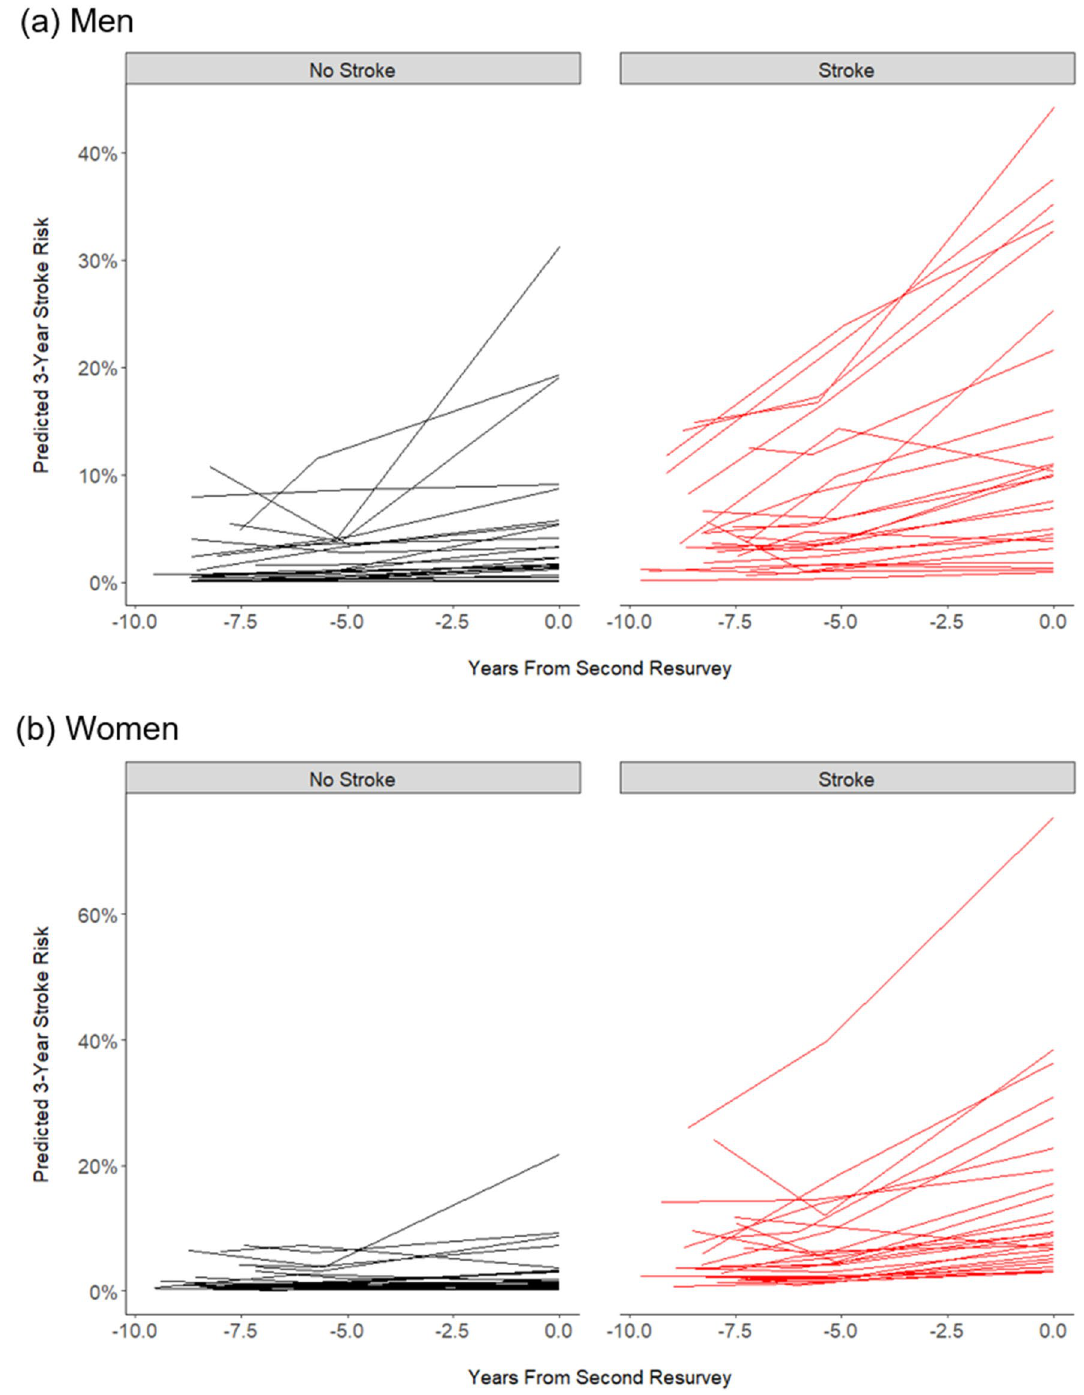
Figure 1. Temporal trends in predicted 3-year stroke risk for a random sample of ( a ) 50 men and ( b ) 50 women from the China Kadoorie Biobank, stratified by incident stroke